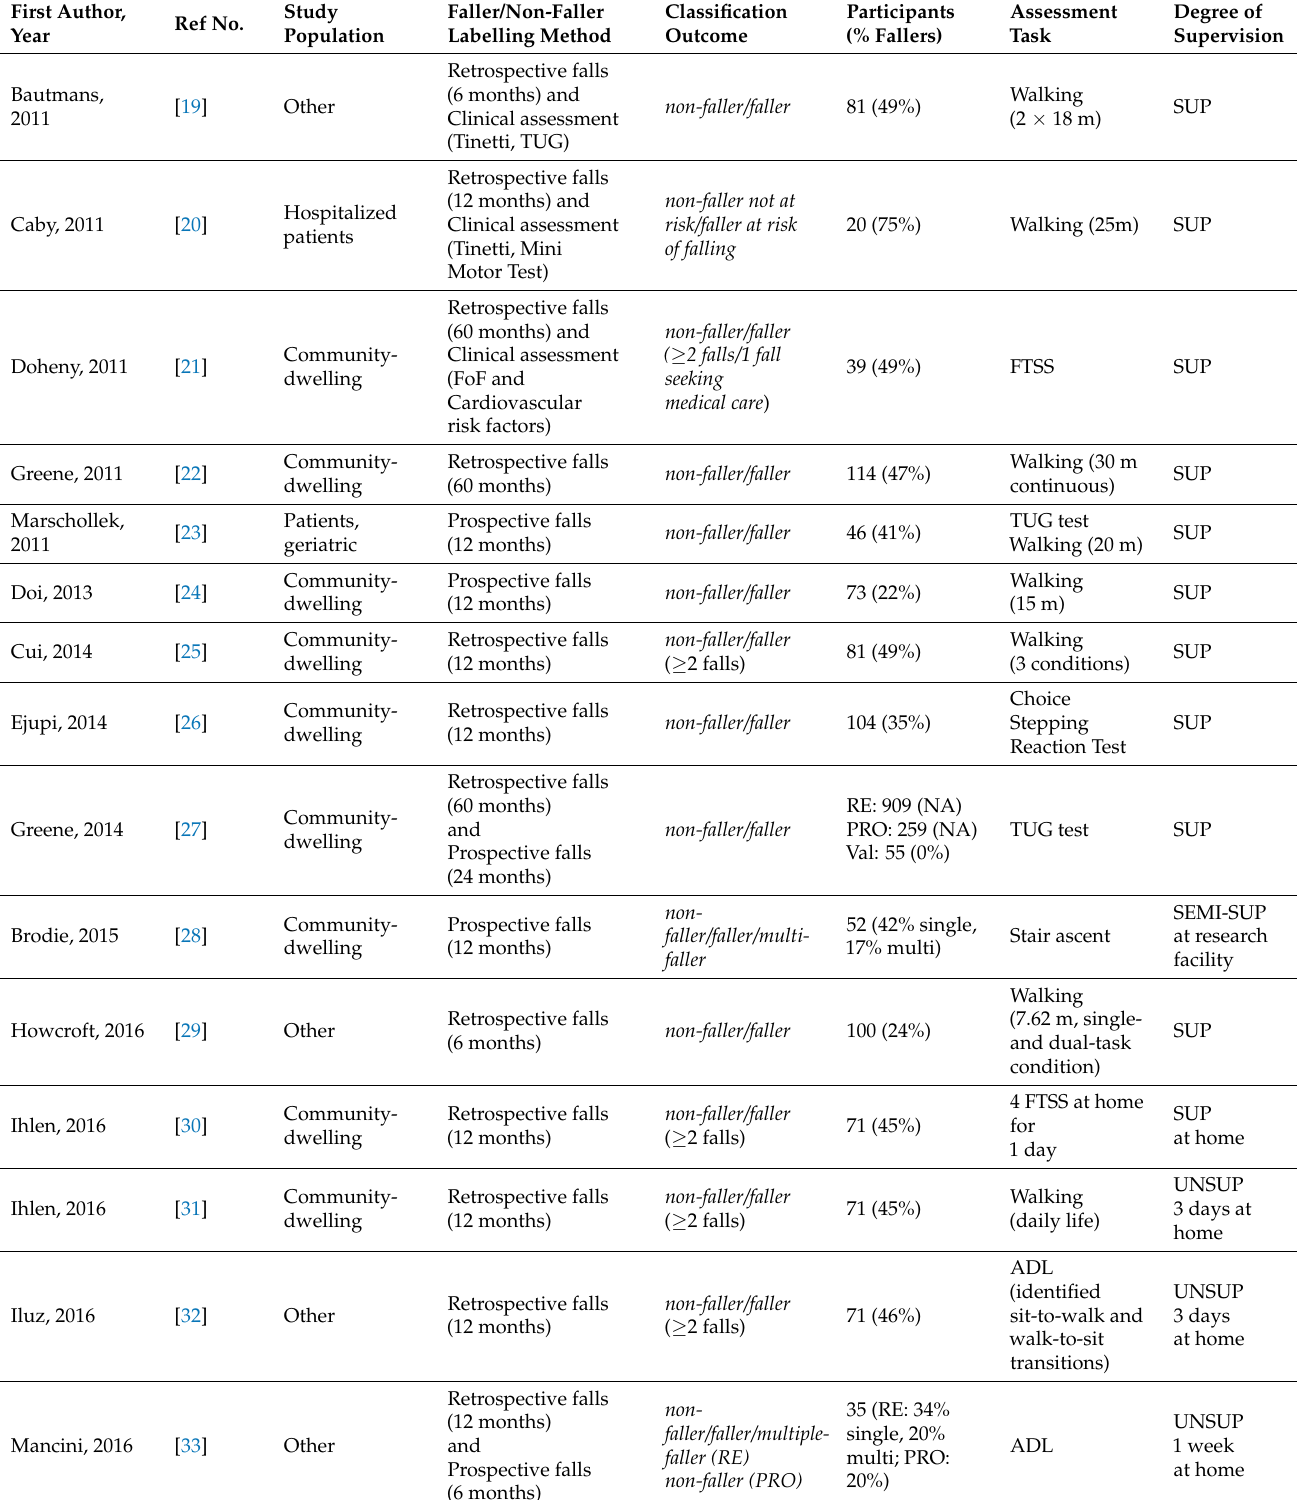
Table 3. Characteristics of included studies. ADL = activity in daily life, FoF = Fear of Falling, FTSS = 5 times Sit-to-stand test, SEMI-SUP = Semi-supervised, SUP = Supervised, 6MWT = Six-Minutes Walking Test, UEF = Upper extremities’ function, UNSUP = Unsupervised, Val = Validation, VR = Virtual